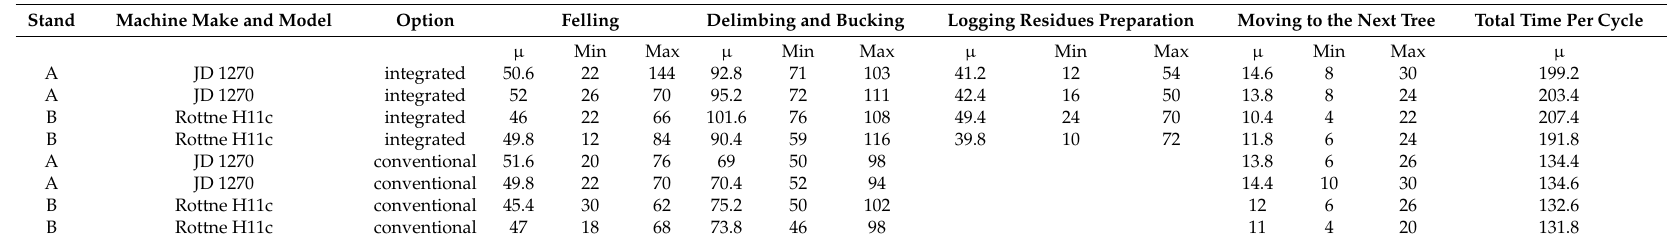
Table 2. Time consumption in the harvesting operation.